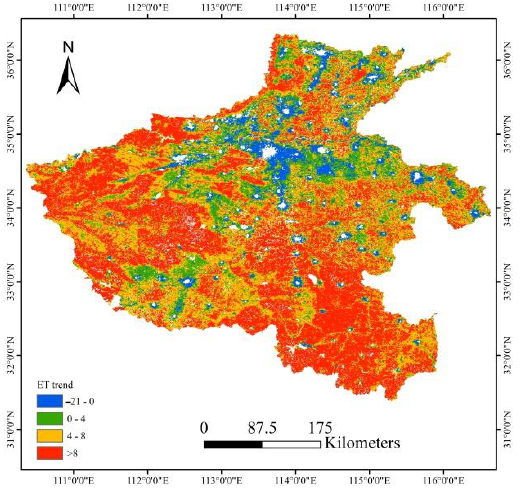
Figure 8. Spatial distribution of annual average NDVI during 2000 – 2020.